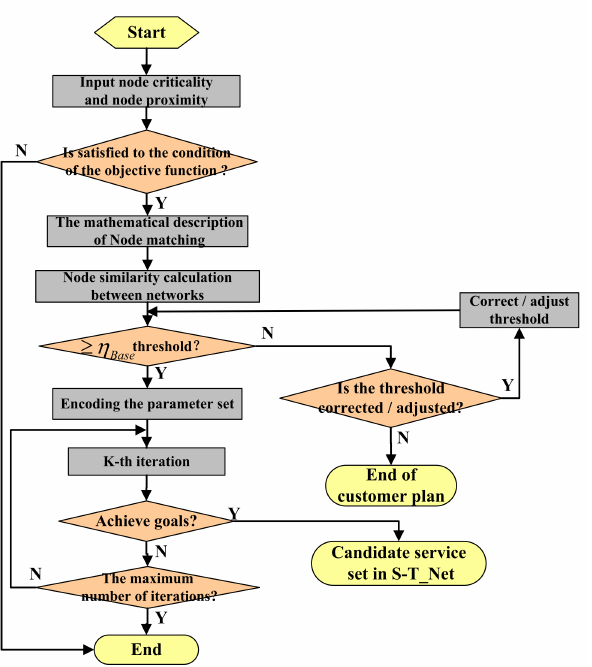
Figure 5. The flowchart of task-service network node matching based on the Multi-Objective opti- mization